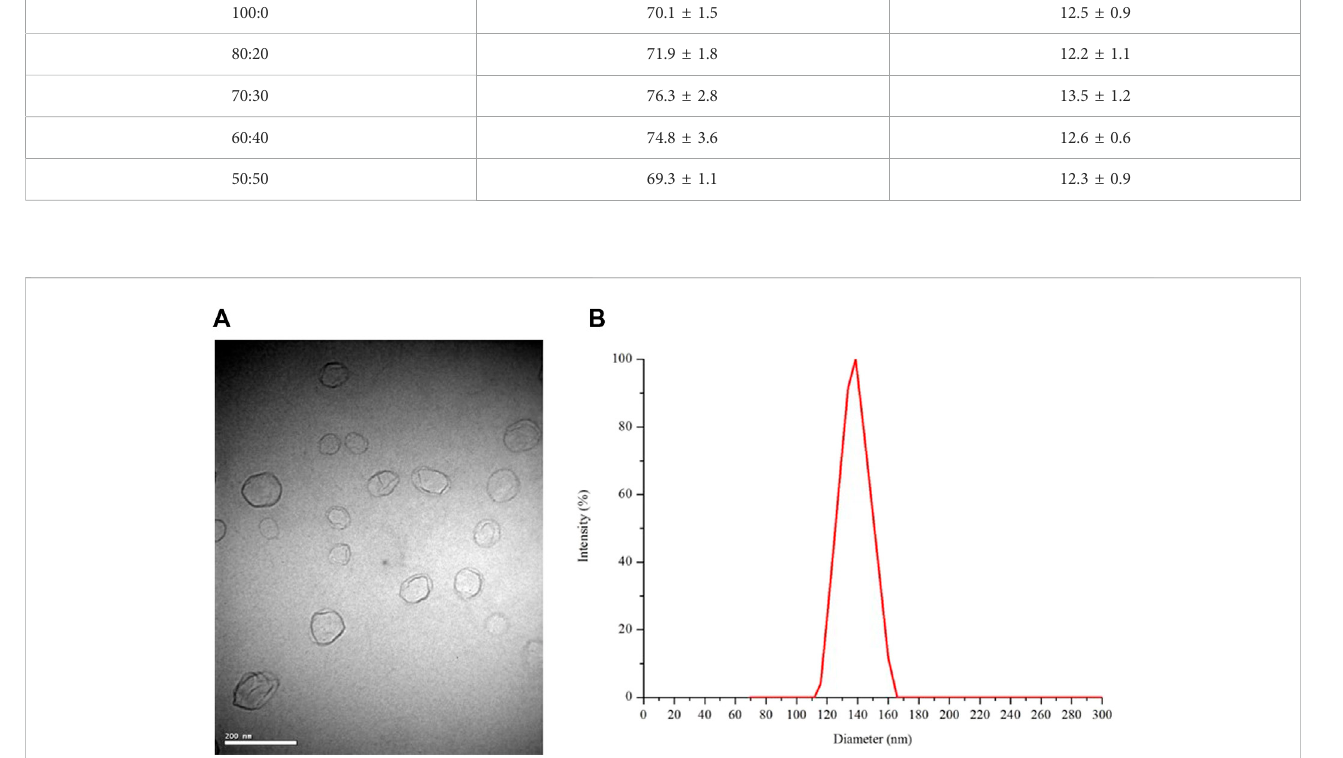
FIGURE 1 TEM image at 10,000 times magni fi cation (A) and the size distribution of freeze-dried Ng liposomes (B) .